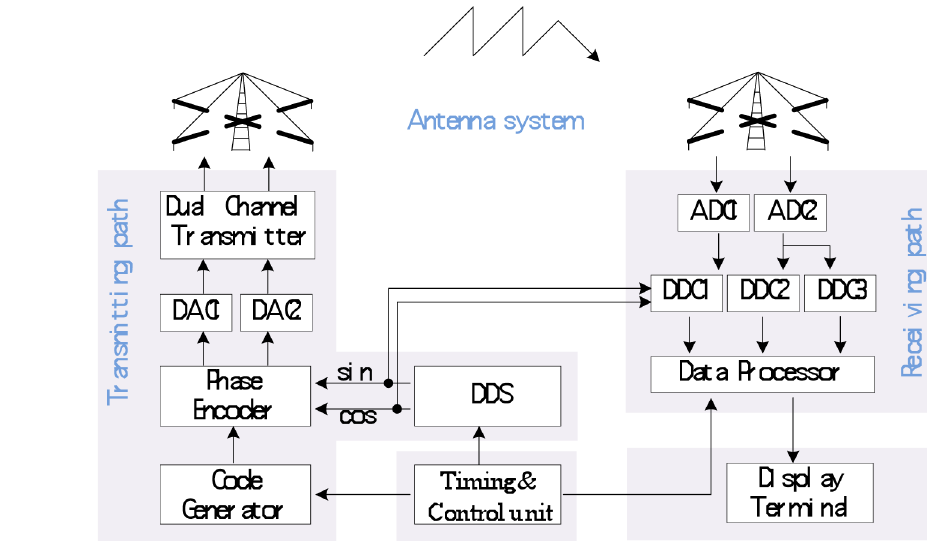
Figure 1. Block diagram of CAS-DIS ionosonde.